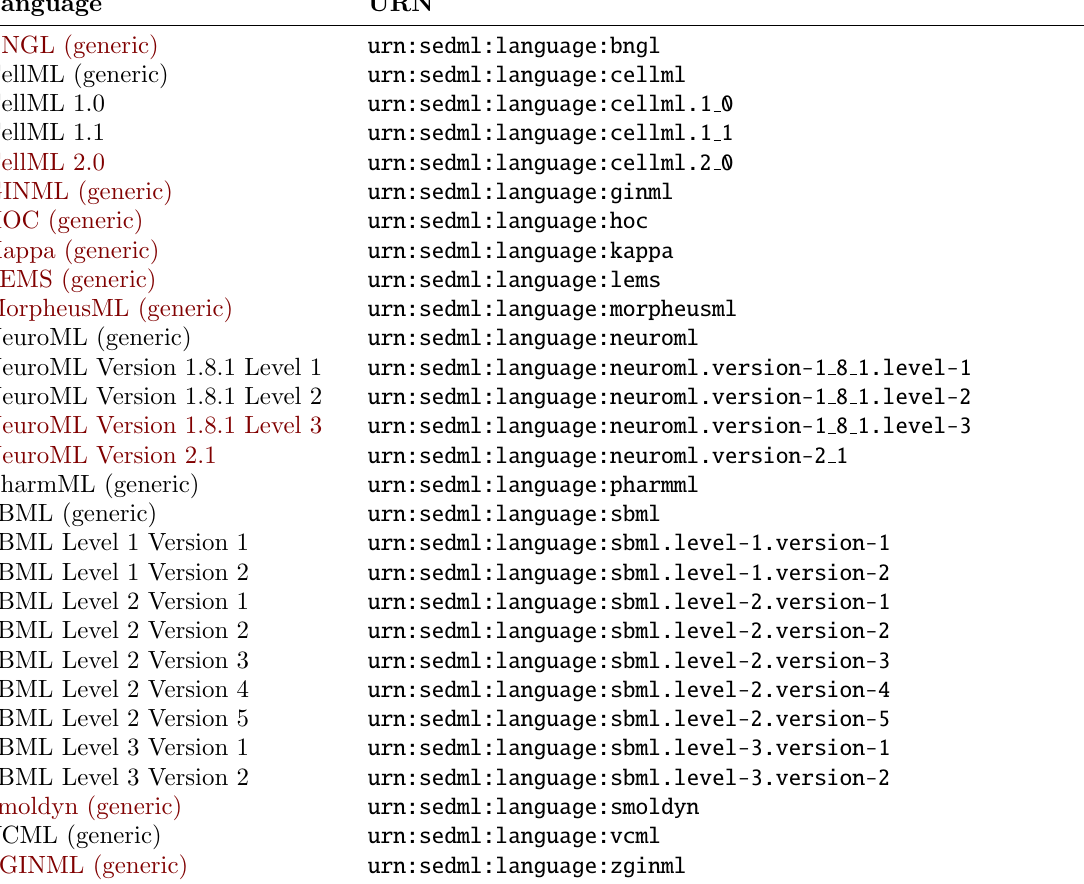
Table 3.2: Predefined model language URNs. The latest list of language URNs is available from https://sed-ml.org/urns.html .